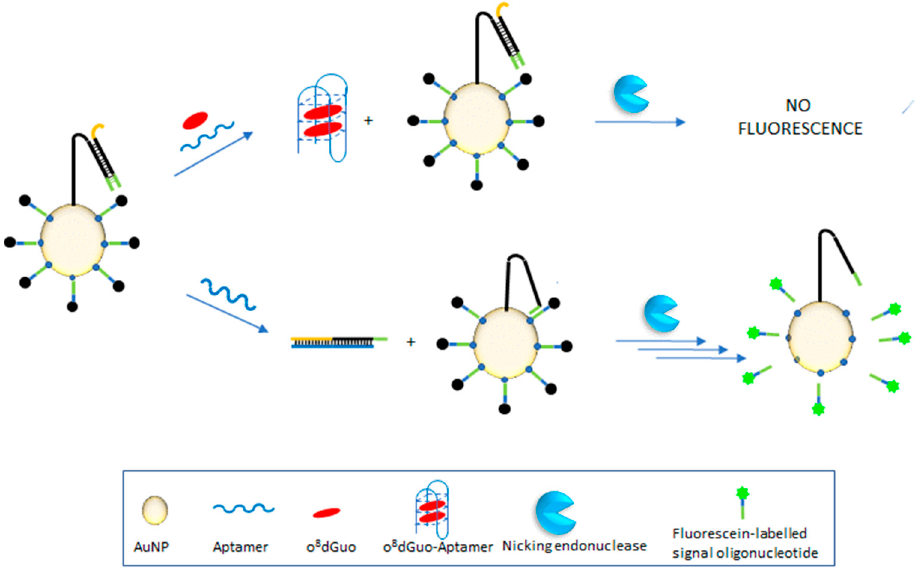
Figure 9. Three-dimensional (3D) nanomachine-assisted detection of o 8 dGuo lesions [37].